Question: Author a descriptive caption for the visualization shown.
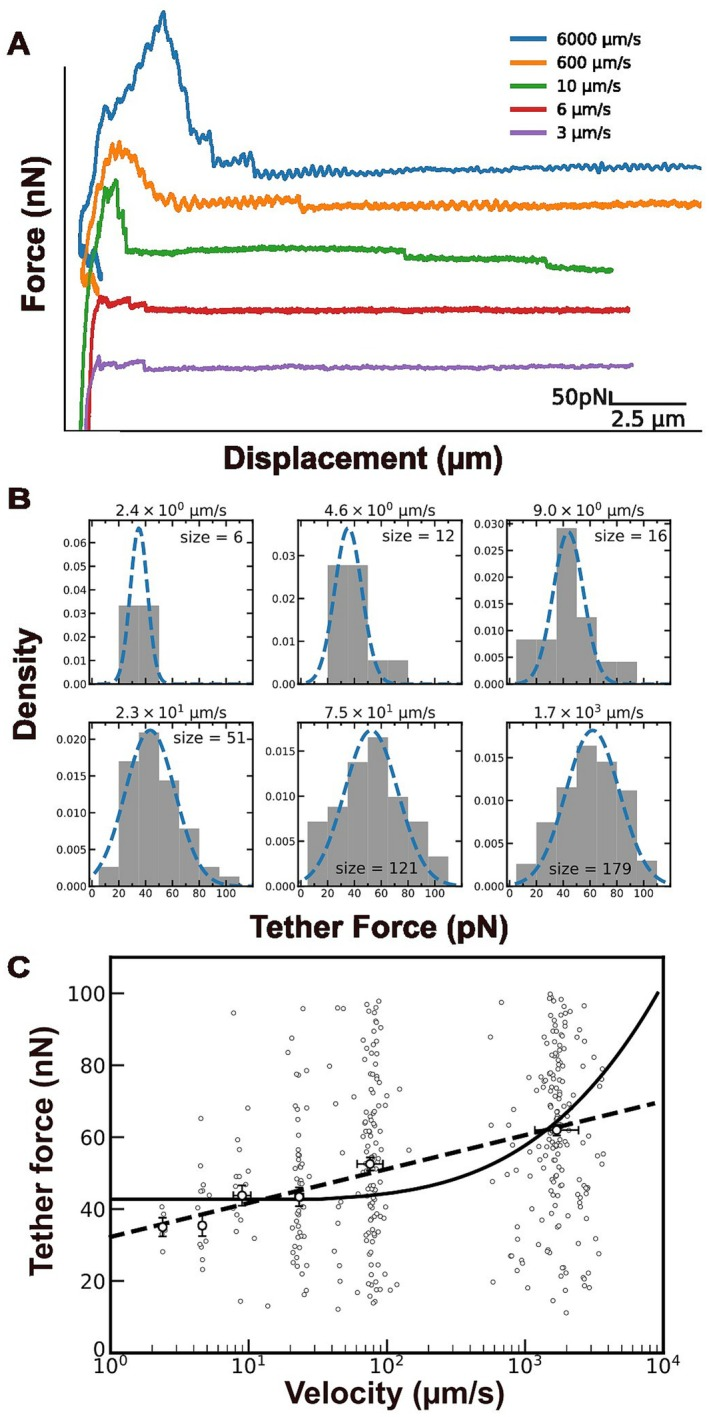
Answer: (A) Retract segment of various force–displacement curves at divergent velocities, showing tether events, evident as plateaus followed by sharp force steps. (B) Histograms of tether extraction forces at six different velocities (grey bars). A Gaussian fit (blue, dashed line) was used to determine the most probable force (vertical, blue, solid line). (C) Most probable tether extraction forces versus retraction velocity ranging 3–6000 μ m/s. The solid line is the best fit of the Brochard–Wyart model and dashed line is a logarithmic fit.